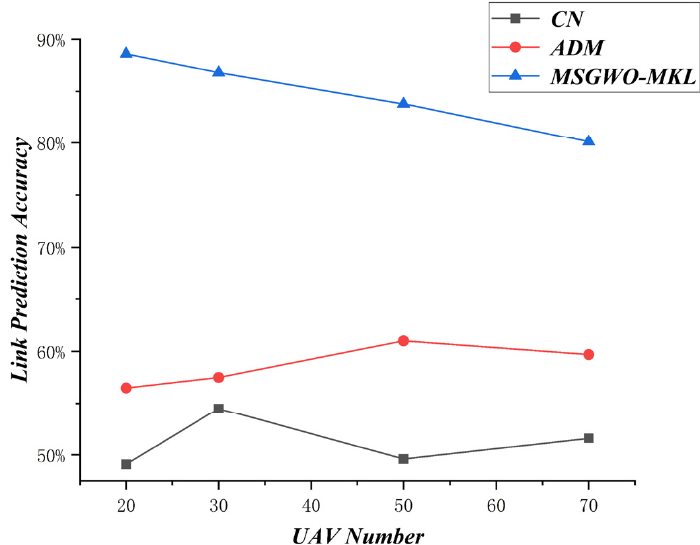
Figure 20. Variation of accuracy about UAV number.